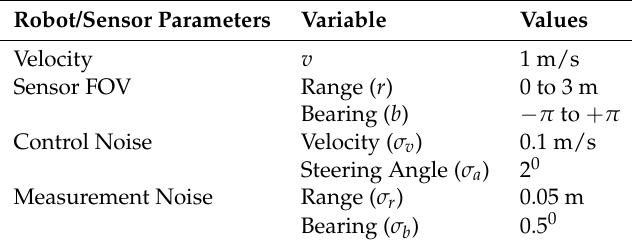
Table 1. Parameters used in the